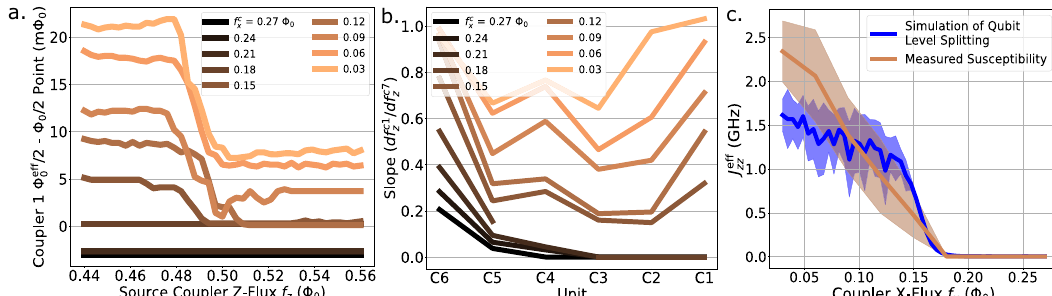
Fig. 4 Cross Chain Susceptibility. a The effective one-half magnetic fl ux quantum points for Coupler 1's main loop as a function of Coupler 7's f z for different homogeneous coupler f x settings. The response becomes non-zero in the vicinity of the couplers' f x = 0.15 Φ 0 . The offset of = 2 (cid:3) Φ = 2 average value from zero and the in fl ection point of Coupler 1's fl ux response from Coupler 7's f = Φ both Coupler 1's Φ eff 0 z 0 /2 is due 0 = 2 (cid:3) Φ = 2 with respect to Coupler 7's f to slight mistunings of the couplers' longitudinal fi elds. It is the change in Coupler 1's Φ eff 0 z that is the 0 relevant quantity. The uncertainty in the extracted values is identical to those in Fig. 3. b The curves in a , and the corresponding fi gures for the other units, were then fi t to a sigmoid function. Displayed here is the midpoint slope extracted from those fi ts for all units for different homogeneous coupler f x settings. The error bars were generated by repeating this procedure many times with small offsets picked from a normal distribution with standard deviation of 1.2 m Φ 0 applied to the nominal effective symmetry point values. The error bars are the resultant standard deviation of the large array of slopes extracted from the fi t sigmoid function. c) Using the slopes from b for Coupler 1, the calculated from the effective coupling between the two qubits is calculated via Eqs. (9) and (10) and displayed. This is compared to J eff q 1 q 2 splitting of the otherwise degenerate qubit transitions as predicted by full device simulations incorporating reasonable levels of fl ux noise. indicate that the optimal operating region of the chain is coupler The strong agreement between the two different measures of J eff q 1 q 2 0.15 ≲ f x ≤ 0.18 Φ 0 , where there is signi fi cant coupling strength and, as shown in Fig. 5, both the detrimental effects of fl ux noise and the qubit- coupler state mixing is